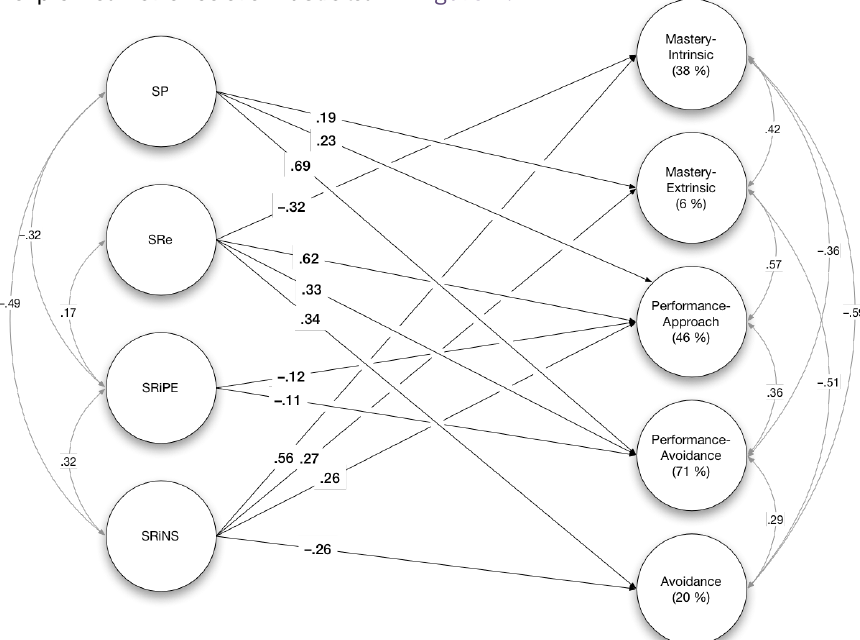
Figure 1. Results of ESEM-SEM analysis with Geomin rotation of achievement goal orientations (confirmatory factors) predicted from temperamental reward and punishment sensitivities (exploratory factors). For clarity, observed variables and corresponding factor loadings are omitted, and only significant ( p < .05) effects ( β ) and correlations are